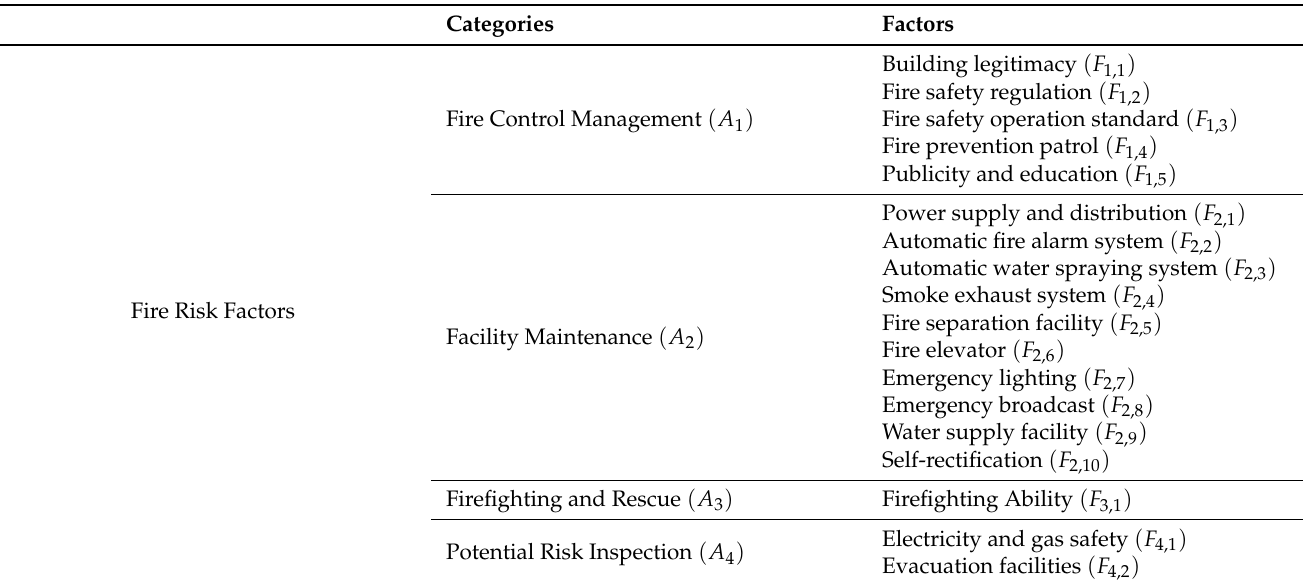
Table 1. Fire-risk indexing